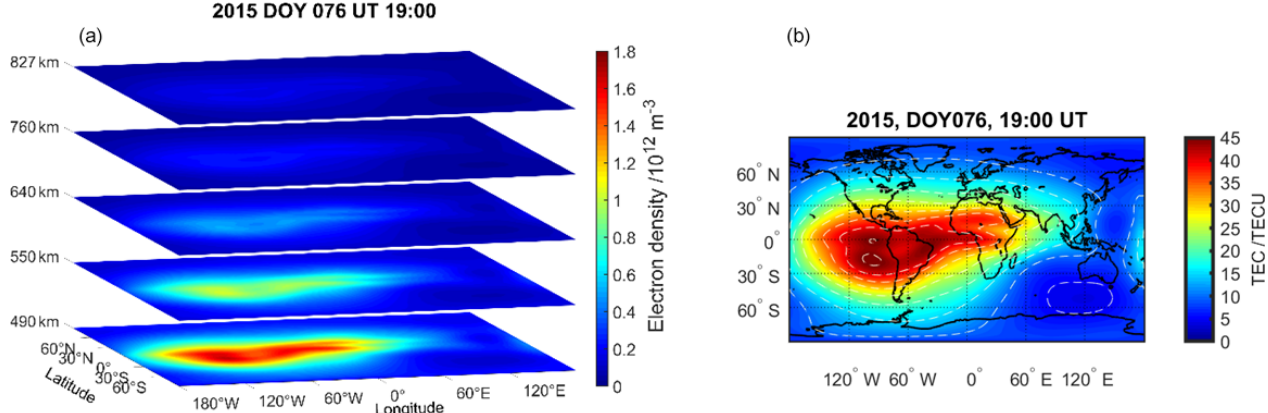
Figure 3. Method rotation reconstructed electron density represented by layers at different heights between 490 and 827km (a) , and a vertical TEC map deduced from the reconstructed 3D electron density in the altitude range between 450 and 20200km (b)